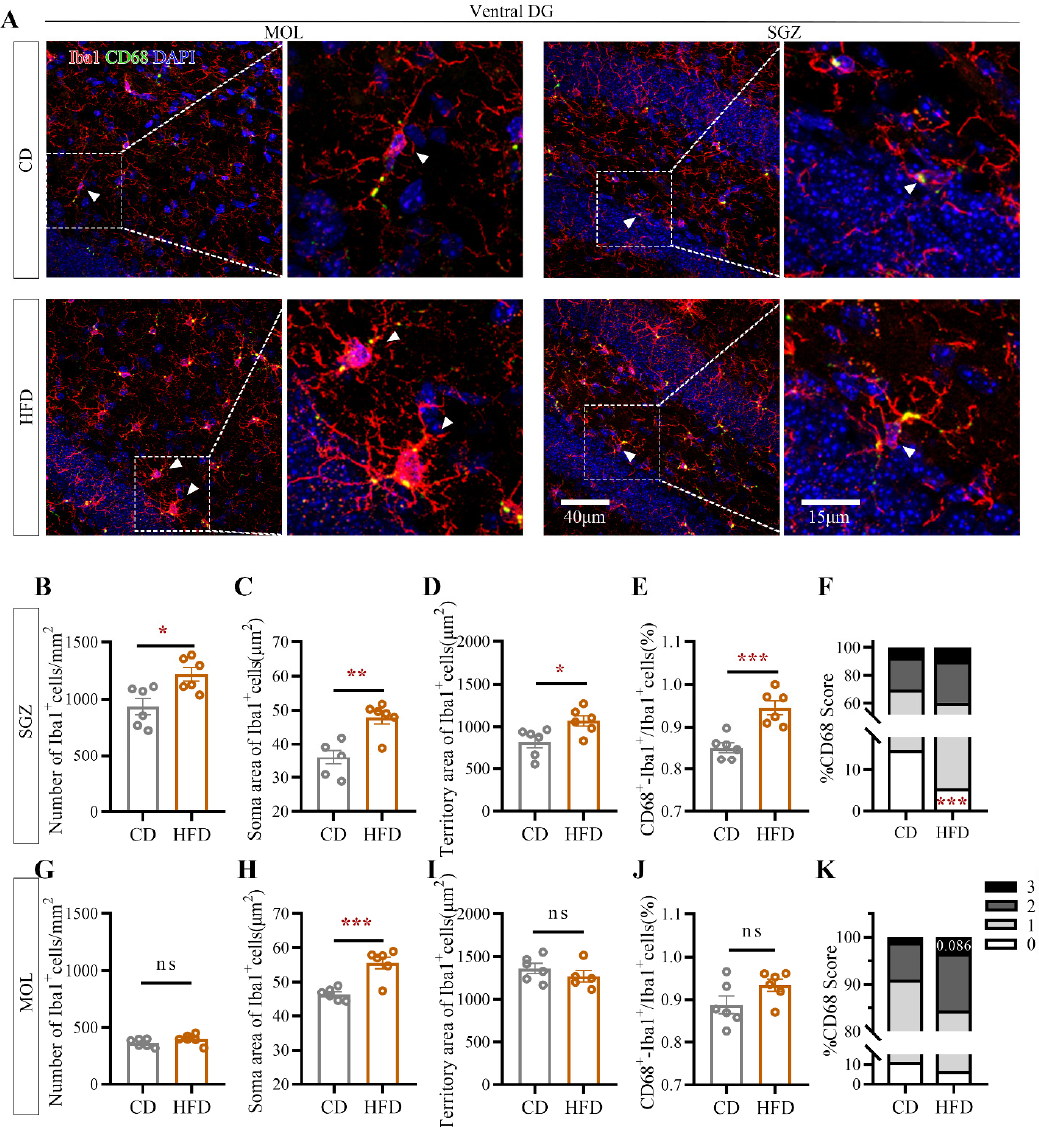
Figure 6. Effect of HFD consumption in adolescence on microglia in the mouse ventral hippocampus. ( A ) Fluorescence staining of Iba1 + and CD68 + cells in the ventral hippocampus of CD and HFD mice. Red, green, and blue fluorescence represent Iba1, CD68, and DAPI, respectively. The microglial density, average microglial soma area, average microglial territory area, percentage of CD68 + microglia, and percentage of CD68 + microglia with a score of 0 to 3 in the SGZ ( B – F ) and MOL ( G – K ) of the ventral hippocampus. The data are expressed as the mean ± SEM ( n = 6 mice per group). When the HFD group was compared with the CD group, the data were analyzed using Student’s t -test. ns, not significant; * p < 0.05; ** p < 0.01; *** p < 0.001.